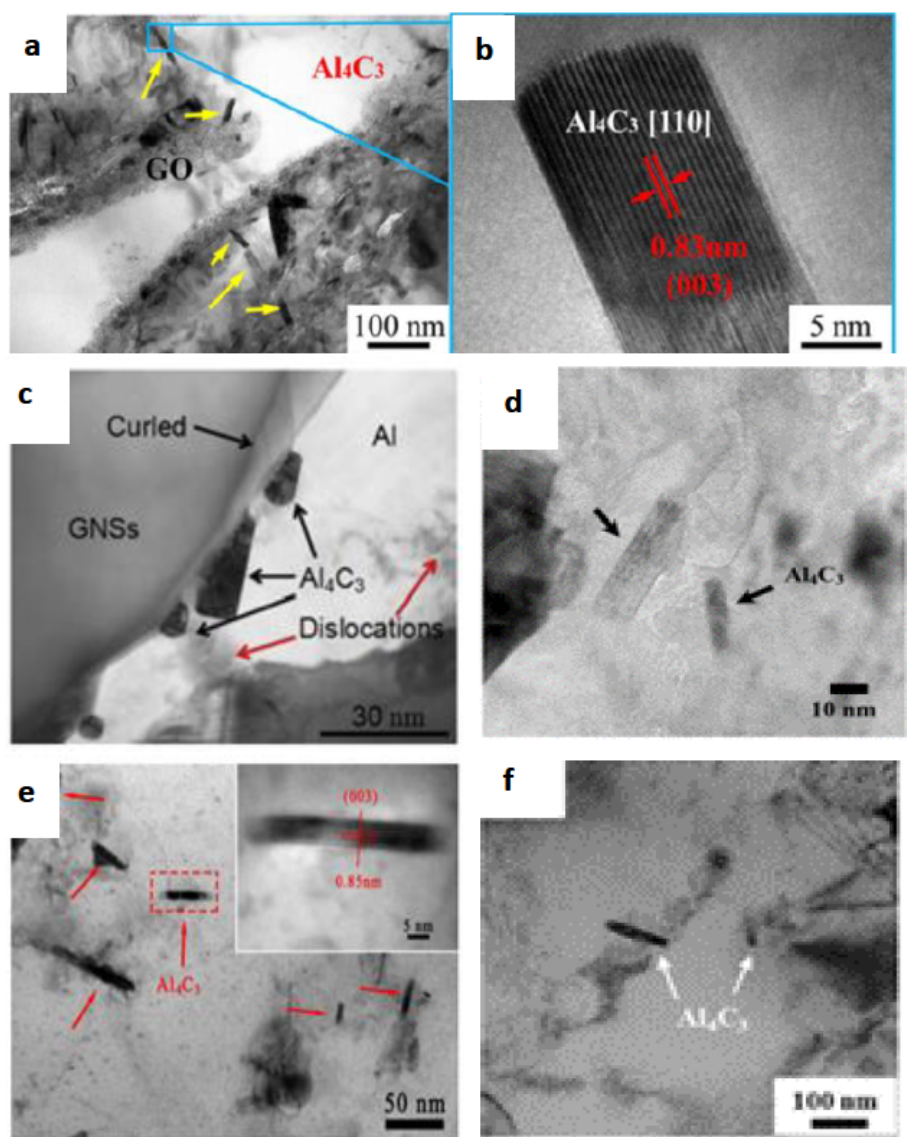
Figure 18: A collection of TEM images showing rod-like structure of Al 4 C 3 phase. Reproduced from the following references: (a, b) [87], (c) [27], (d) [23], (e) [55], and (f) [95].